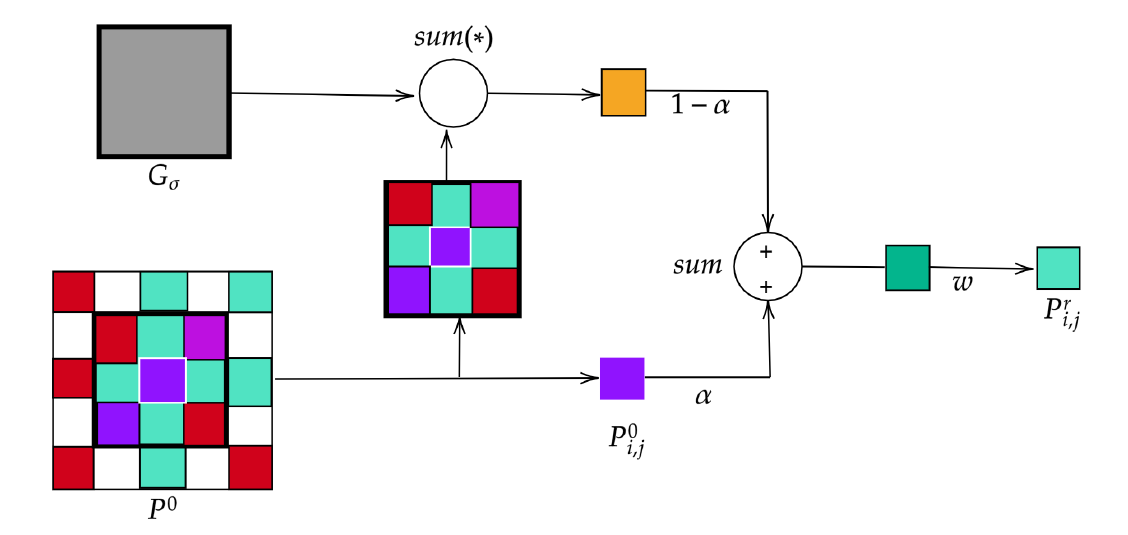
Figure 8. Scheme of the post-processing technique based on iterative label